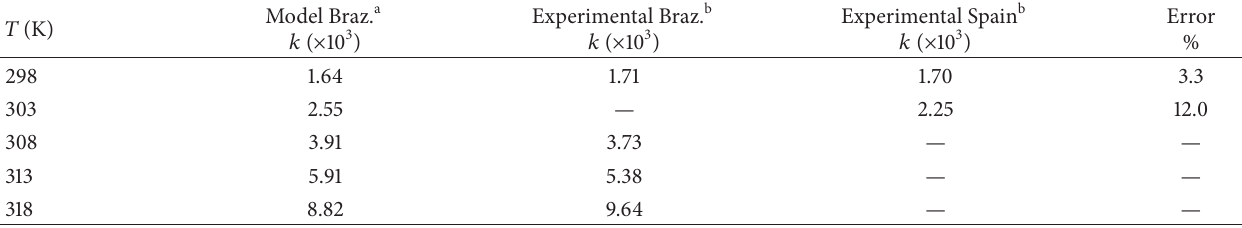
Table 3: The influence of temperature ( 𝑇 ) on the rate constant value ( 𝑘 ) for the kinetic decay PAA method developed. 𝑇 (K)